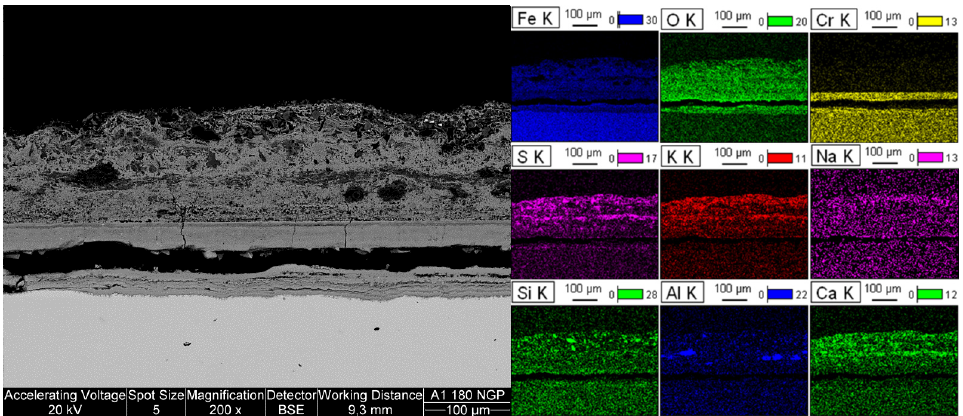
Figure 6. SEM (BSE) image of the outer surface of the FeCr coating and energy ‐ dispersive X ‐ ray spectroscope (EDX) map analysis from the windward ( a ) and leeward side ( b ).